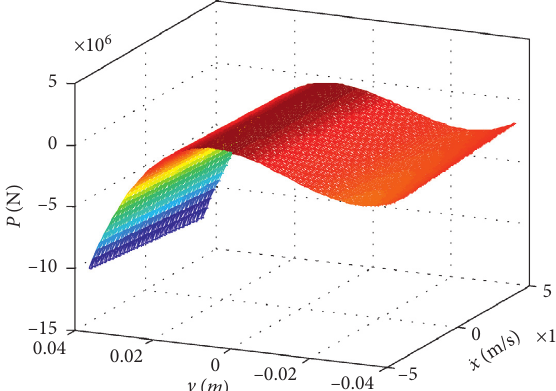
Figure 5: Curve of rolling force affected by the coupling of vertical vibration displacement and horizontal vibration velocity.